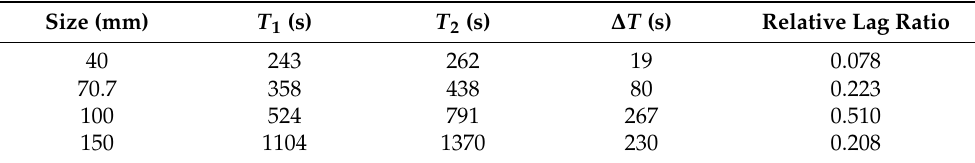
Table 3. Ringing count peak relative stress peak lag